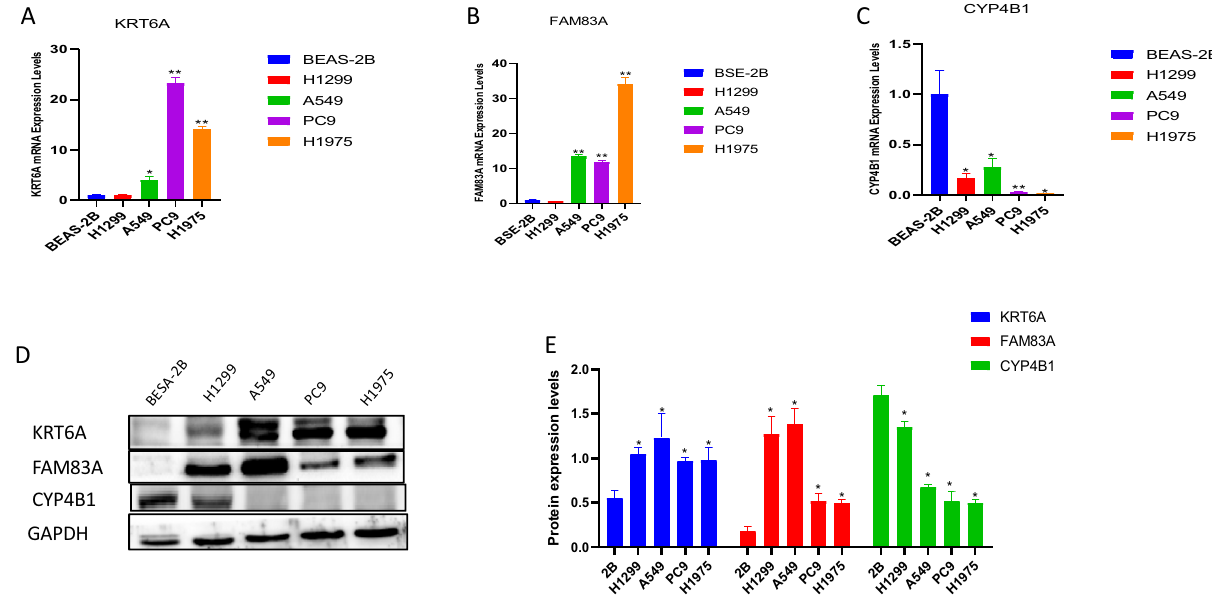
Figure 9. Expression levels of risk genes in normal and tumor cells. ( A – C ), MRNA expression levels of KRT6A ( A ), FAM83A ( B ) and CYP4B1 ( C ) in normal and lung adenocarcinoma cells. ( D , E ), Protein expression level of risk genes.